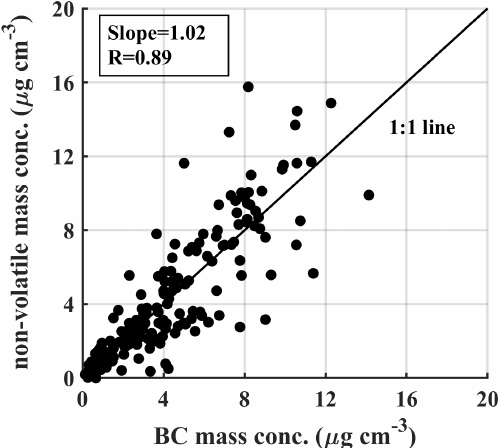
Figure 3. Black carbon (BC) mass concentration measured by AE- 33 vs. the non-volatile mass concentration estimated from the VT- DMA for the winter 2019 period. Estimation of the non-volatile mass concentration was made assuming a density of 1.6gcm − 3 .